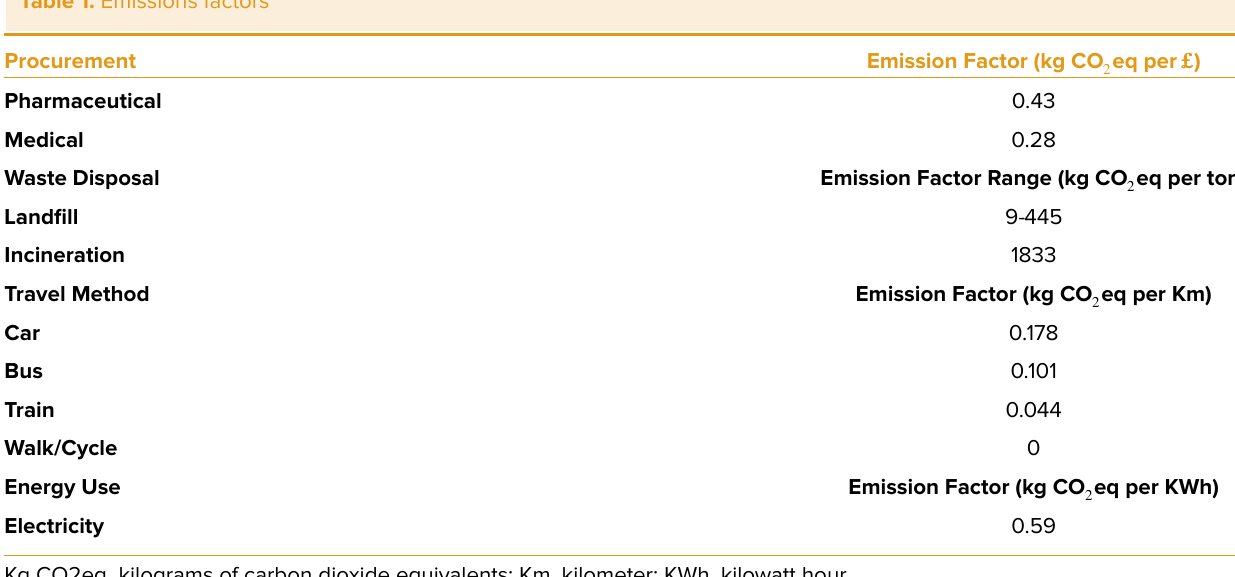
Table 1. Emissions factors